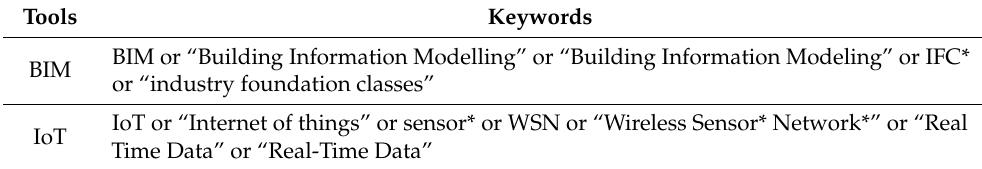
Table 1. Keywords used for research in the two electronic databases of peer-reviewed literature Scopus and Web of Science (WoS). The asterisk “*” after the keywords tells the search engine to look for all the words beginning with that keywords, i.e., “sensor*” tells the search engine to look for the words “sensor”, “sensors”, “sensoring”, etc . . . The quotations marks surrounding two or more words tell the search engine to look for the phrase and not the words, i.e., “industry foundation classes” is use to search for the prhase and not for the words industry or foundation or classes.